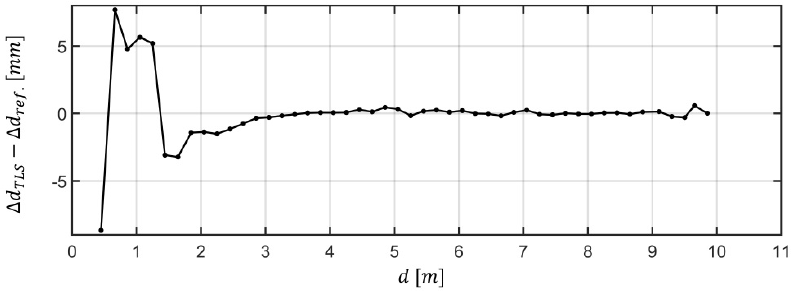
Figure 4. Rangefinder bias in the near-field for the Leica ScanStation P20 with respect to the measurement distance.